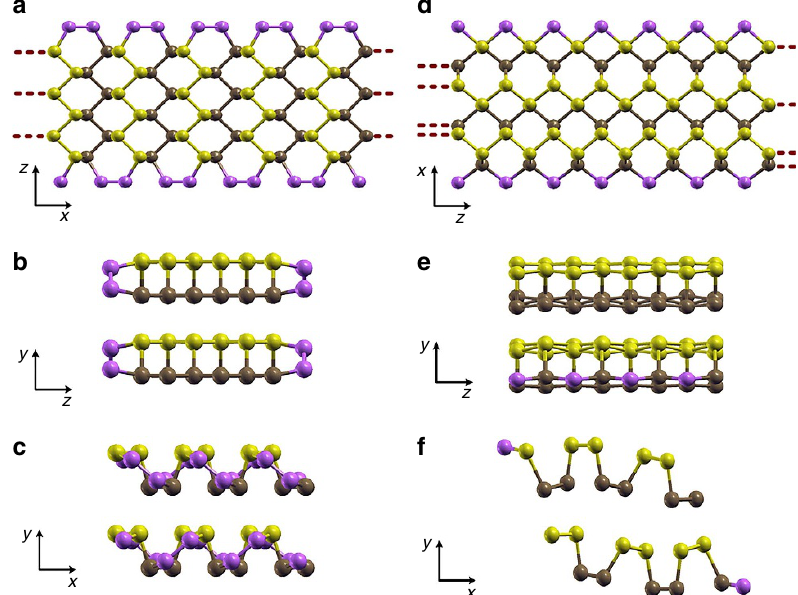
Figure 2 | BP slabs studied by DFT calculations and their corresponding relaxed edges. ( a ) One layer of a BP slab with armchair edges, and the corresponding projections on the ( b ) yz plane and ( c ) xy plane of the unit cell used. ( d ) One layer of a BP slab with zigzag edges, and the corresponding projections on the ( e ) yz plane and ( f ) xy plane. The atoms at the edges of each slab are shown in purple to highlight the atomic rearrangements. The structures are repeated periodically in the y direction in both cases, as well as in the x direction for the armchair slab and in the z direction for the zigzag case.